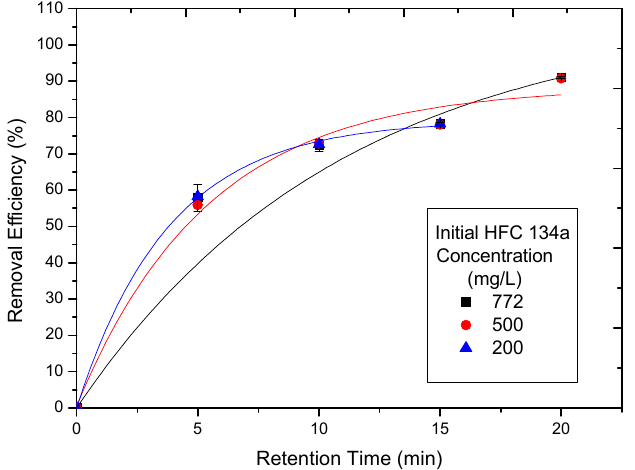
Figure 2. Effect of the initial HFC-134a concentration on the efficiency of HFC-134a removal. (Liquid circulation rate: 80 L/min, air flow rate: 10 L/min).